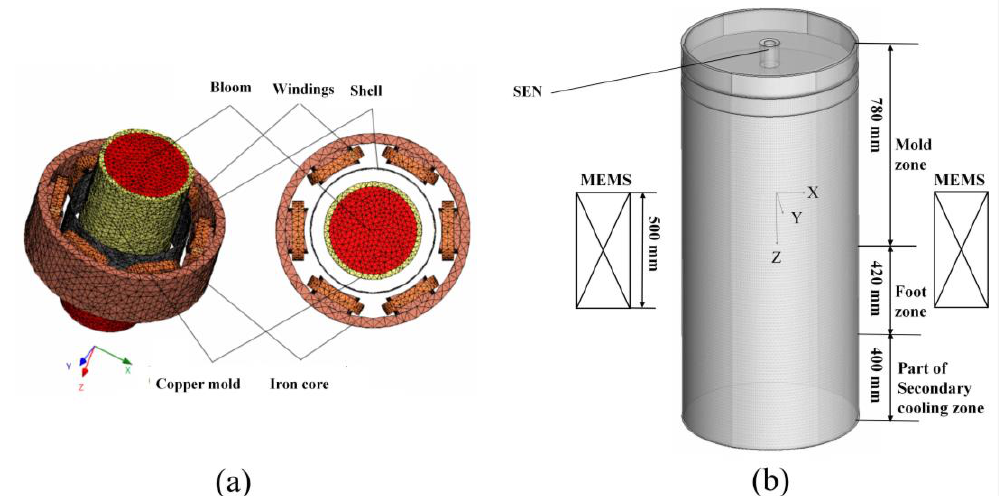
Figure 1. Geometry model and mesh plot in a round bloom strand with MEMS: ( a ) model used for electromagnetic simulation (surrounding air not shown), and ( b ) model used for the flow simulation.